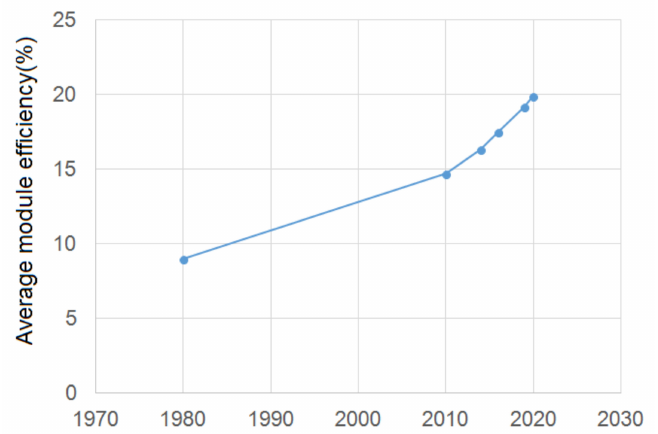
Figure 14. The development of the average efficiency of the produced modules.